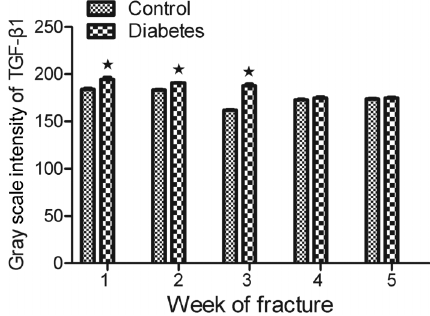
Figure 3. Gray scale intensity of transforming growth factor b 1 (TGF- b 1). The gray scale intensity value of TGF- b 1 expression was higher in the diabetes group than in the control group at postoperative weeks 1, 2, and 3. The difference between groups was signi fi cant (*P o 0.05, t